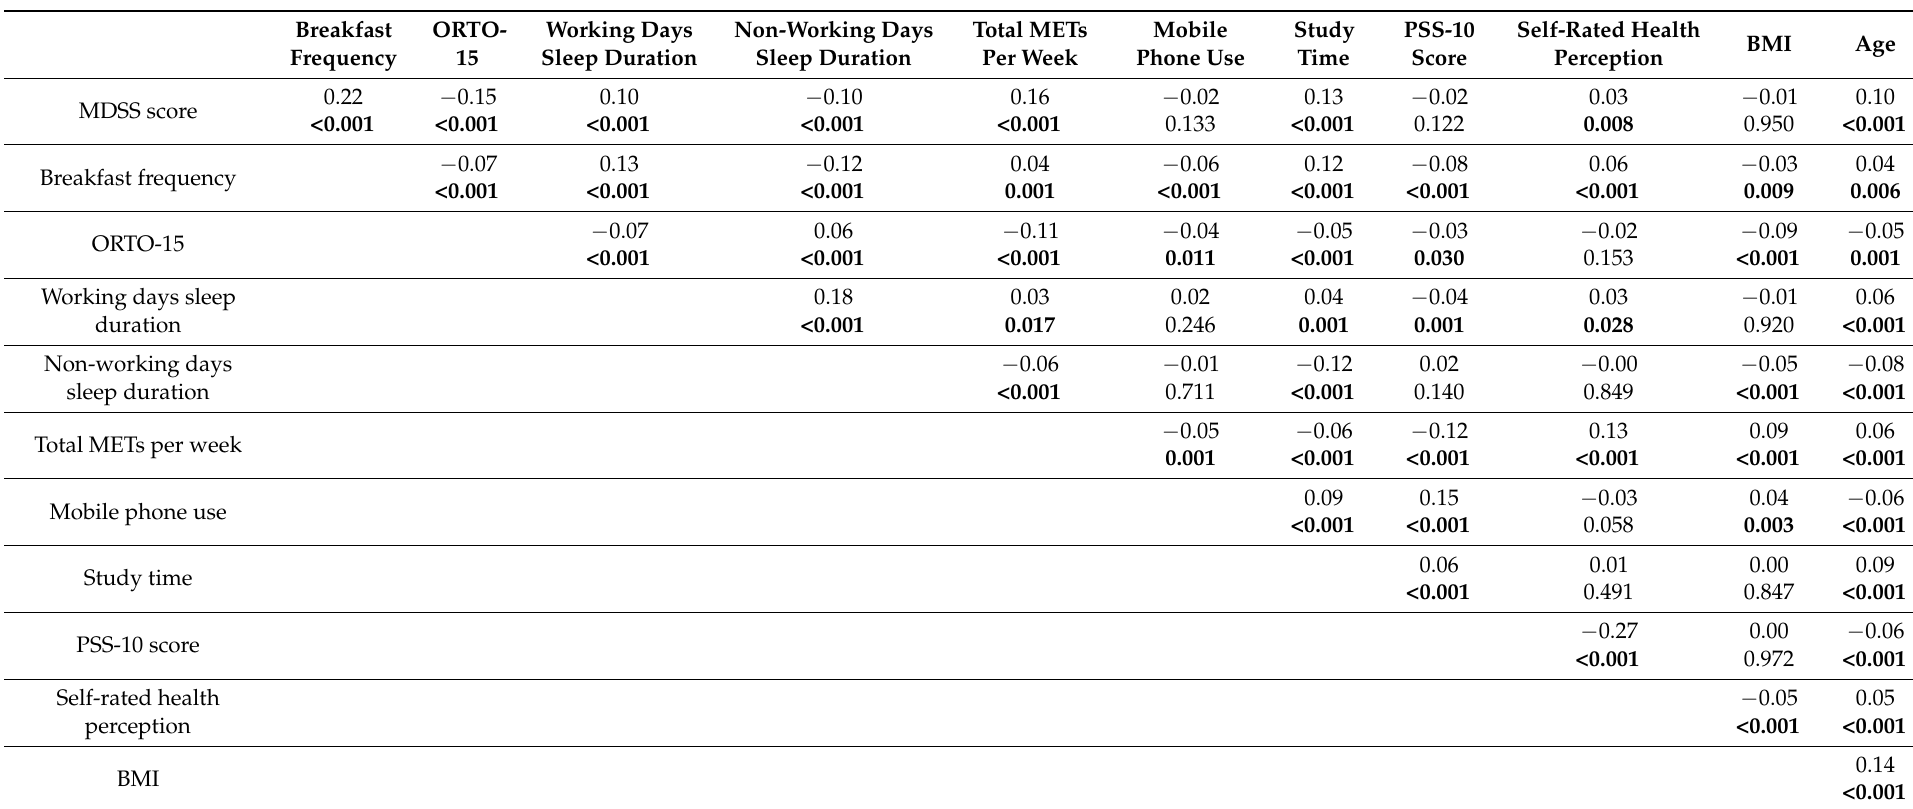
Table 2. Correlation between lifestyle habits, self-perceived health, BMI and age in the overall sample ( n = 6222); data are presented as Spearman’s correlation coefficients and p values. Breakfast ORTO- Frequency